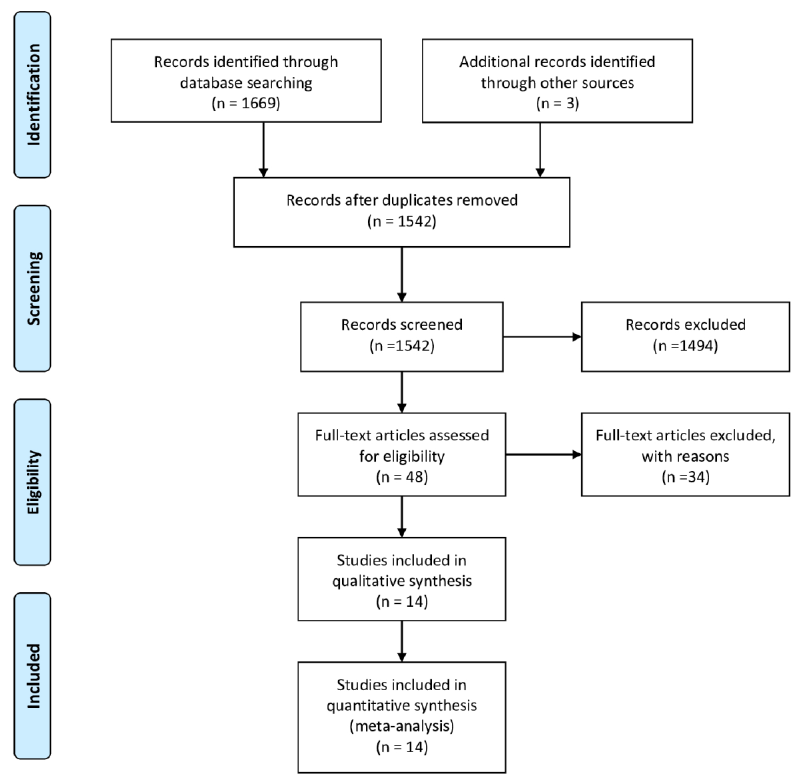
Figure 1. Preferred Reporting Items for Systematic Reviews and Meta-Analysis (PRISMA) flow diagram of the literature selection process, including identification, screening, eligibility and total studies included in qualitative and quantitative